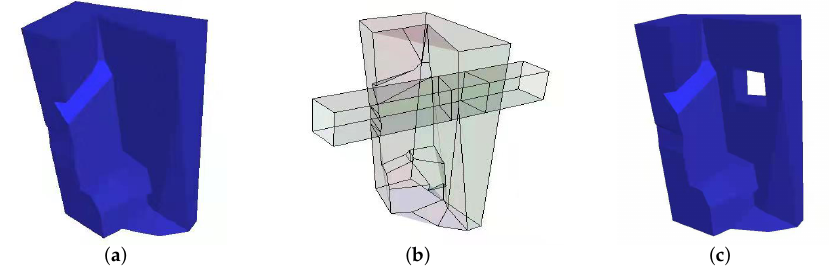
Figure 19. Example of adding tunnel information to rock mass model ( a ) Input model. ( b ) Add tunnel information. ( c ) Block after